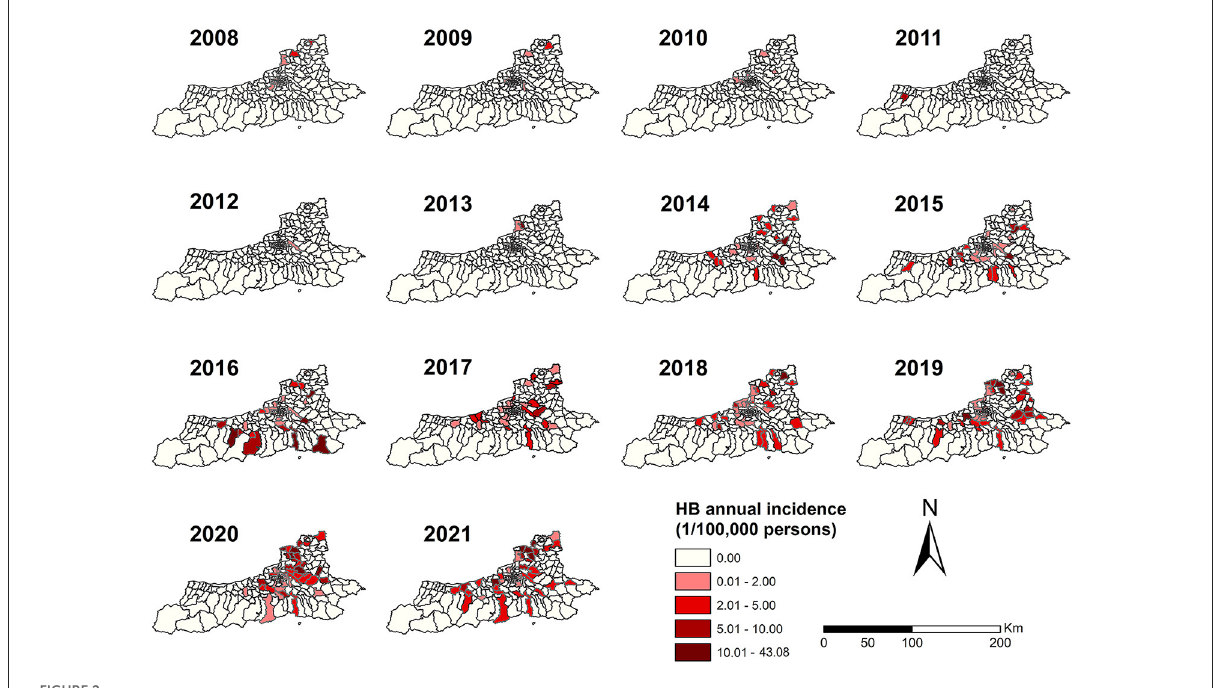
FIGURE2 Spatial and temporal distributions of human brucellosis in Xi’an, 2008–2021.